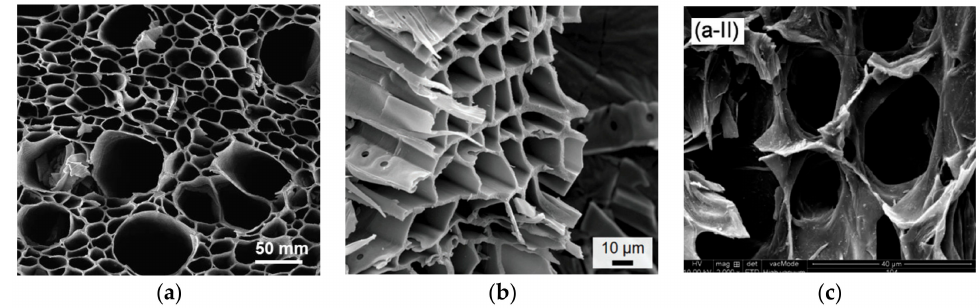
Figure 3. SEM images of biochar from the pyrolysis of ( a ) wood block reprinted with permission from [40]. Copyright (2017) American Chemical Society; ( b ) wood sawdust reprinted with permission from [39]. Copyright (2015) Royal Society of Chemistry; and ( c ) sisal leaves reprinted with permission from [41]. Copyright © 2015, Springer